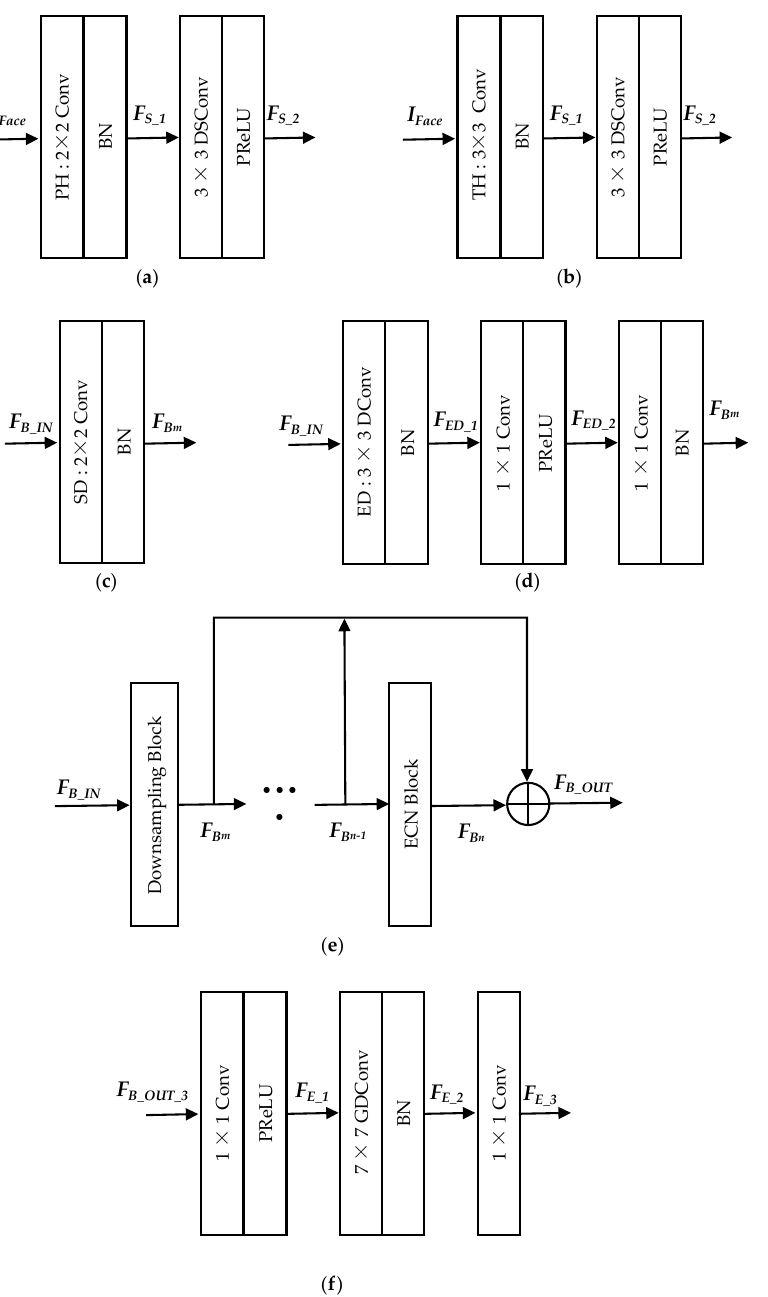
Figure 2. Graphical outline of the proposed ConvFaceNeXt model. ( a ) Stem partition with the patchify head configuration. ( b ) Stem partition with typical head configuration. ( c ) Bottleneck parti- tion with separate downsampling configuration. ( d ) Bottleneck partition with ECN downsampling configuration. ( e ) Linking of blocks with same output dimension for a particular stage in bottleneck partition. ( f ) Embedding partition. Here, ‘PH’ refers to the patchify head, ‘TH’ refers to the typical head, DSConv denotes depthwise separable convolution, ‘SD’ refers to separate downsampling, ‘ED’ refers to ECN downsampling and ‘GDConv’ denotes global depthwise